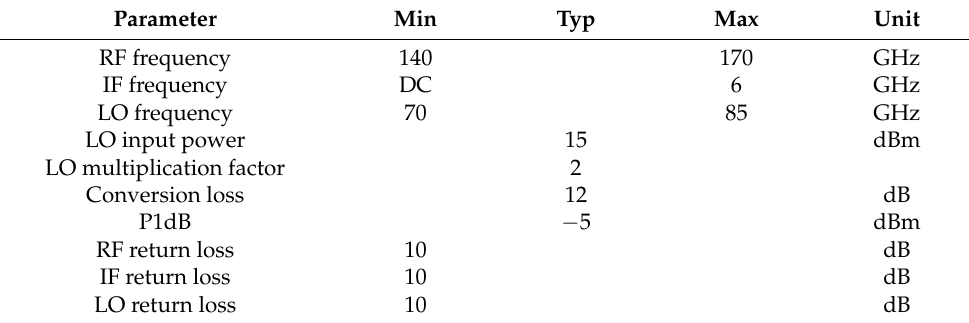
Table 3. Typical performance values of the GMDR0035A chip.